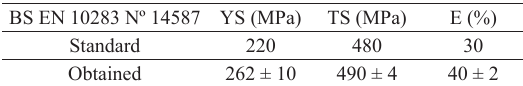
Table 2. Yield strength (YS), tensile strength (TS) and elongation (E) of superaustenitic stainless steel.